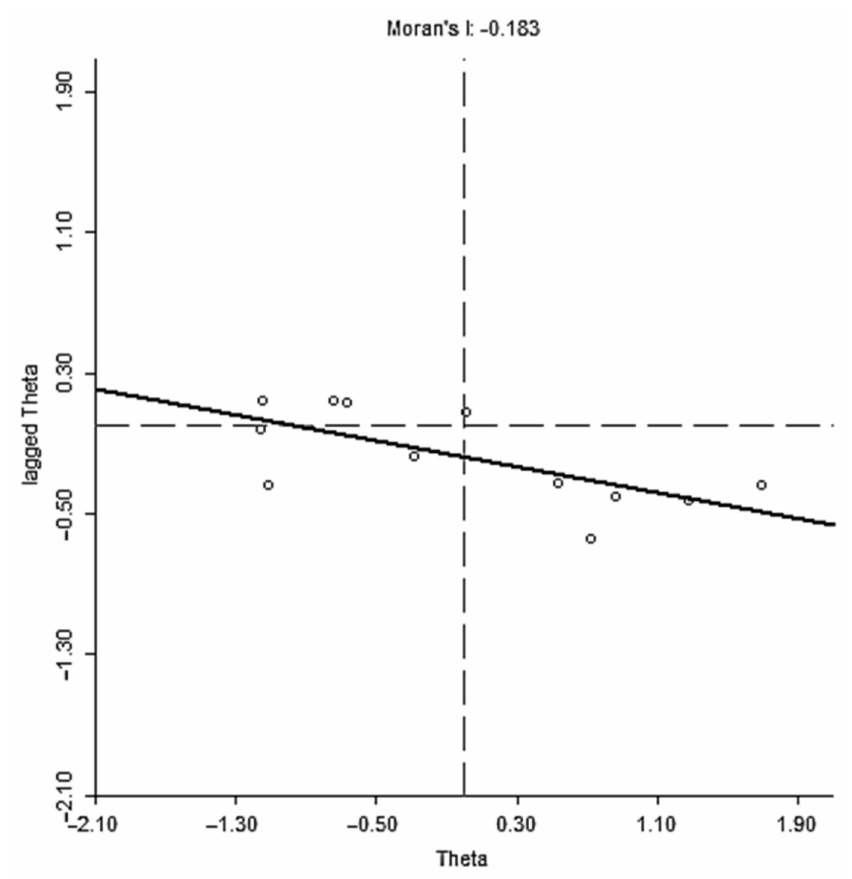
Figure 4. Moran’s scatter plot. Source: own calculations based on data from Table